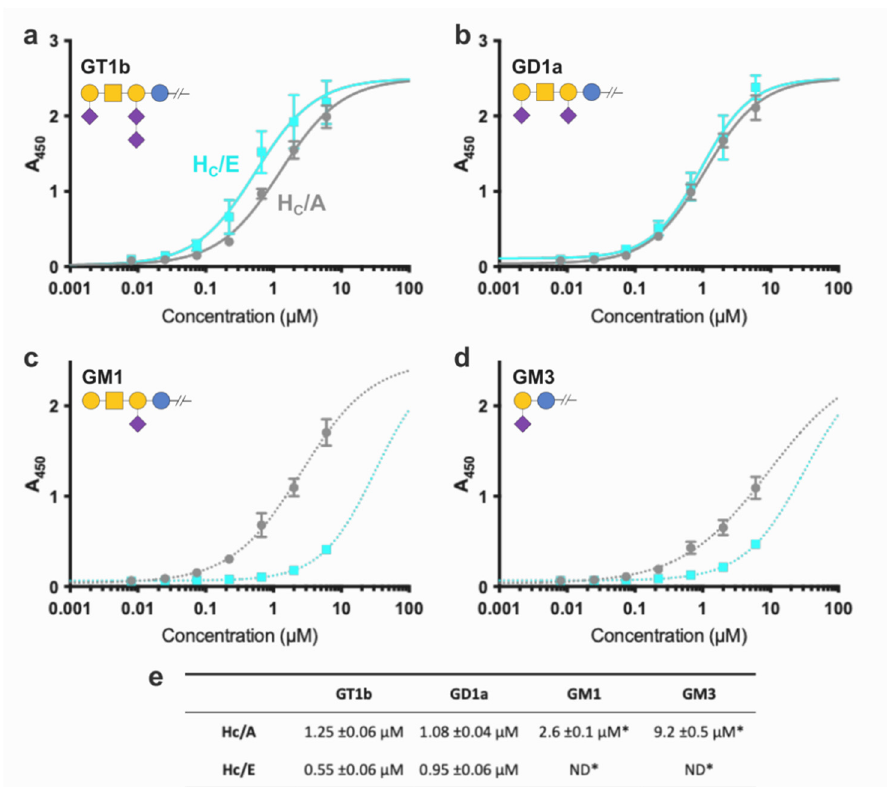
Figure 4. Ganglioside binding. Binding of H C /E (cyan), and H C /A (grey) to GT1b ( a ), GD1a ( b ), GM1 ( c ), and GM3 ( d ). Assays were performed in triplicate. Glycobloc schematic representation [29] of the ganglioside is also included. ( e ) Apparent K d (K d app ) values for each of the fitted binding assays, with standard error. Data marked by (*) were fitted with model parameter limits due to weak binding affinity.